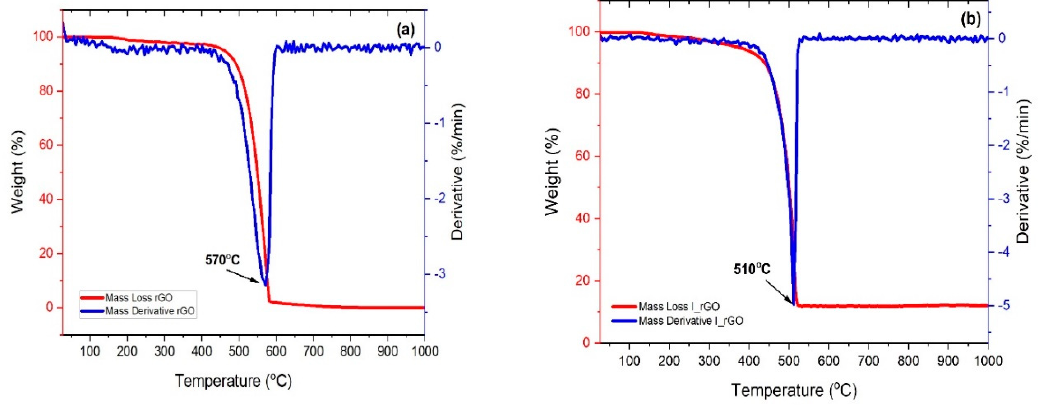
Figure 5. TGA/DTGA plots corresponding to: ( a ) r − GO and ( b ) I/rGO.